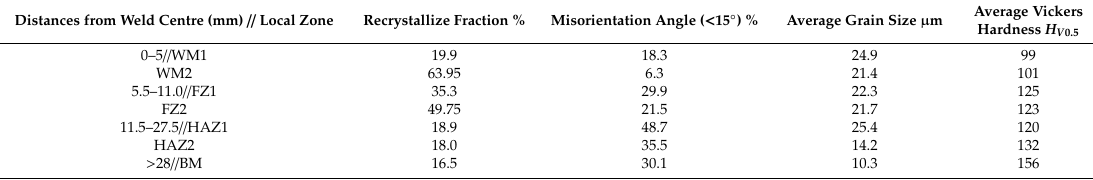
Table 5. Statistical characteristic values of the joint